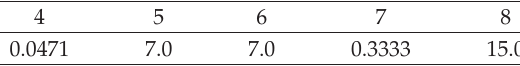
Table 2: Constants K